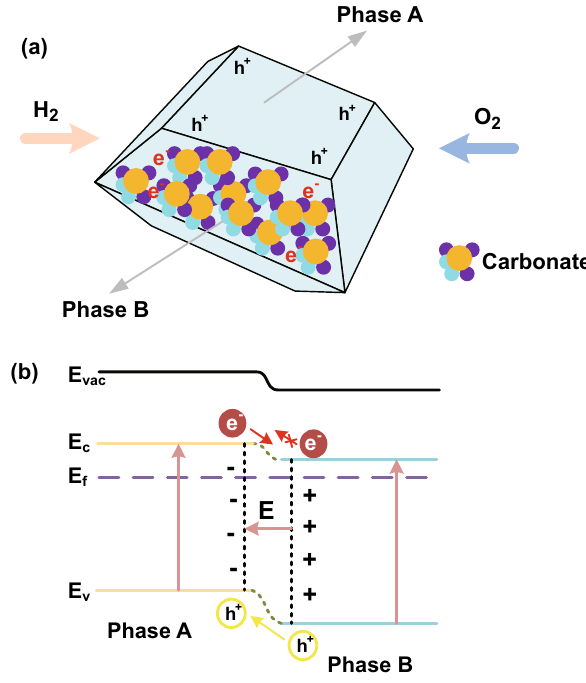
Fig. 13 Illustration of a formation of phase junction in ceria–carbon‑ ate CHC system; b band alignment and BIF in ceria–carbonate CHC